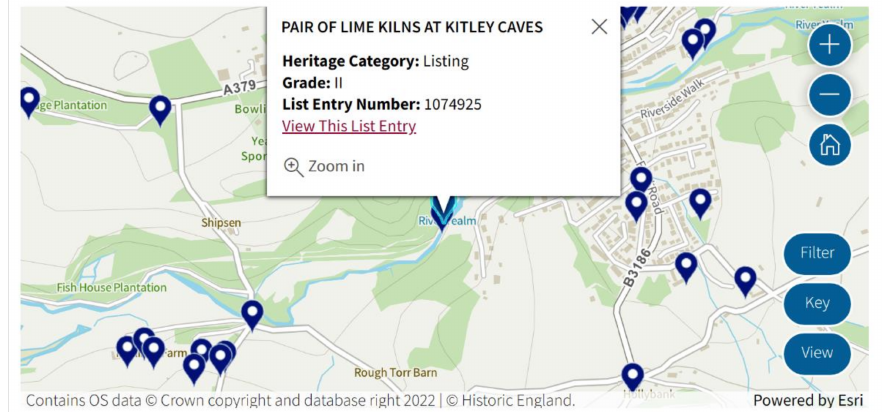
Figure 1. UK Heritage Gateway web site: example of how to identify a historical monument “Pair of Lime Kilns at Kitley Caves” on the digital map associated with the database.